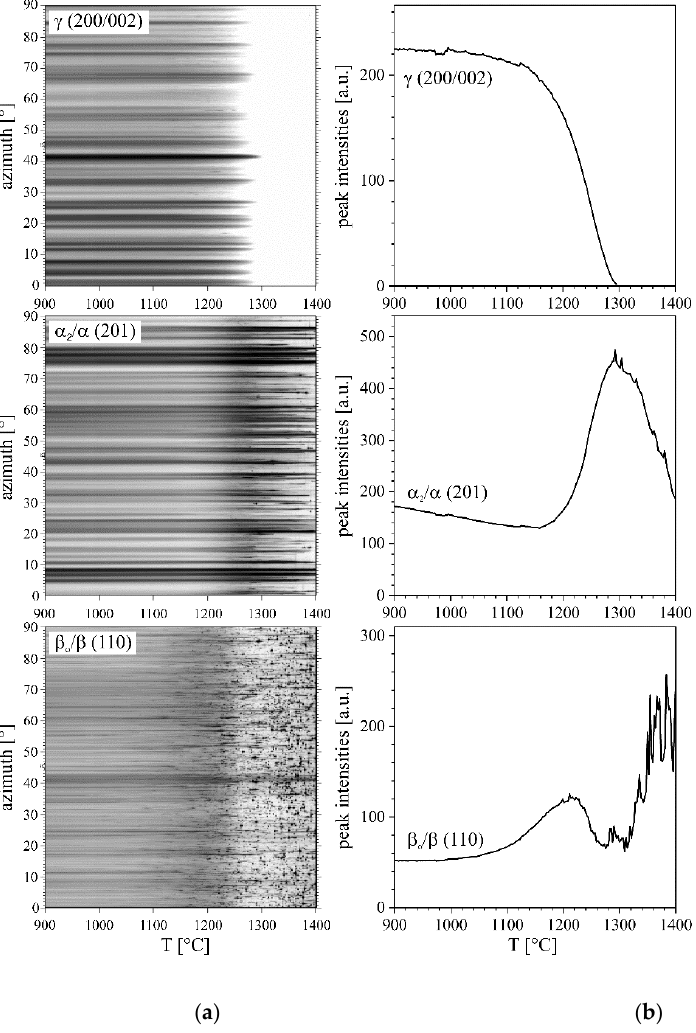
Figure 4. Azimuthal intensity distribution (90° sector) for one reflection of each phase as a function